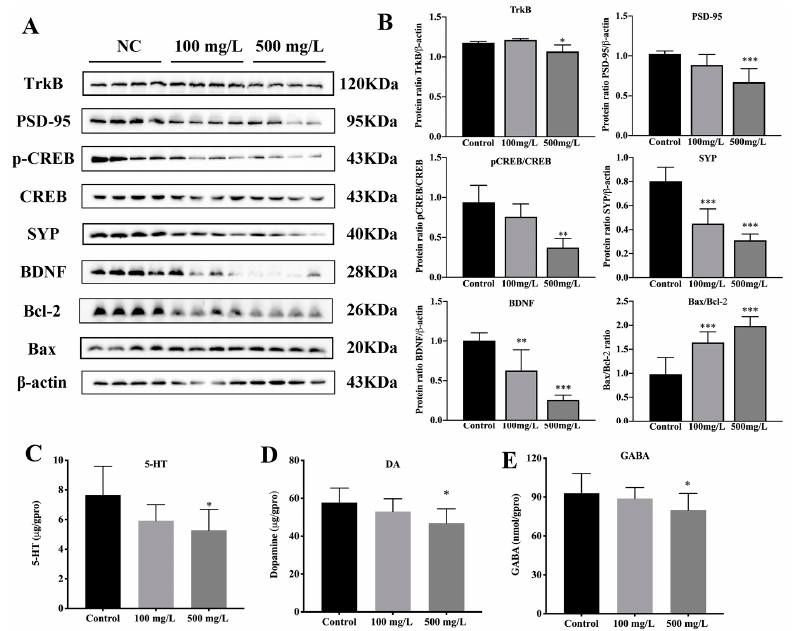
Figure 4. Cu impairs CREB/BDNF signaling of mice hippocampal. ( A ) Effects of Cu on the proteins expression of TrkB, PSD-95, pCREB, CREB, SYP, BDNF and Bax, Bcl-2 in mice hippocampus. ( B ) Quantitative analysis of TrkB, PSD-95, pCREB/CREB, SYP, BDNF and Bax/Bcl-2. ( C – E ) Serotonin (5-HT), dopamine (DA), and γ -aminobutyric acid (GABA) levels in the brain of the mice. * p < 0.05, ** p < 0.01, *** p < 0.001.